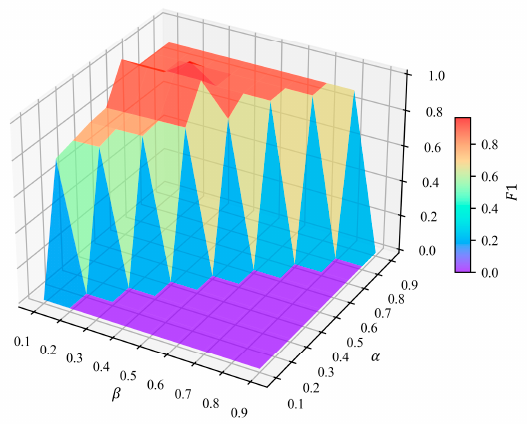
Figure 5. Mushroom’s 𝐹1 change chart.